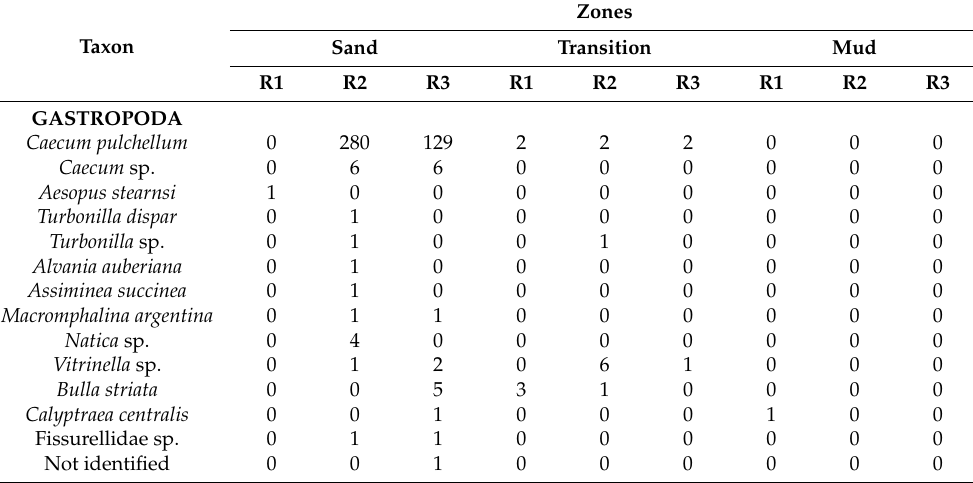
Table A2. Macrofaunal species collected in the three zones (Sand, Transition and Mud) of the study area. Numbers are in ind. 0.01 m − 2 . R1, R2 and R3 refer to the van Veen grab replicate (n = 3) of a given